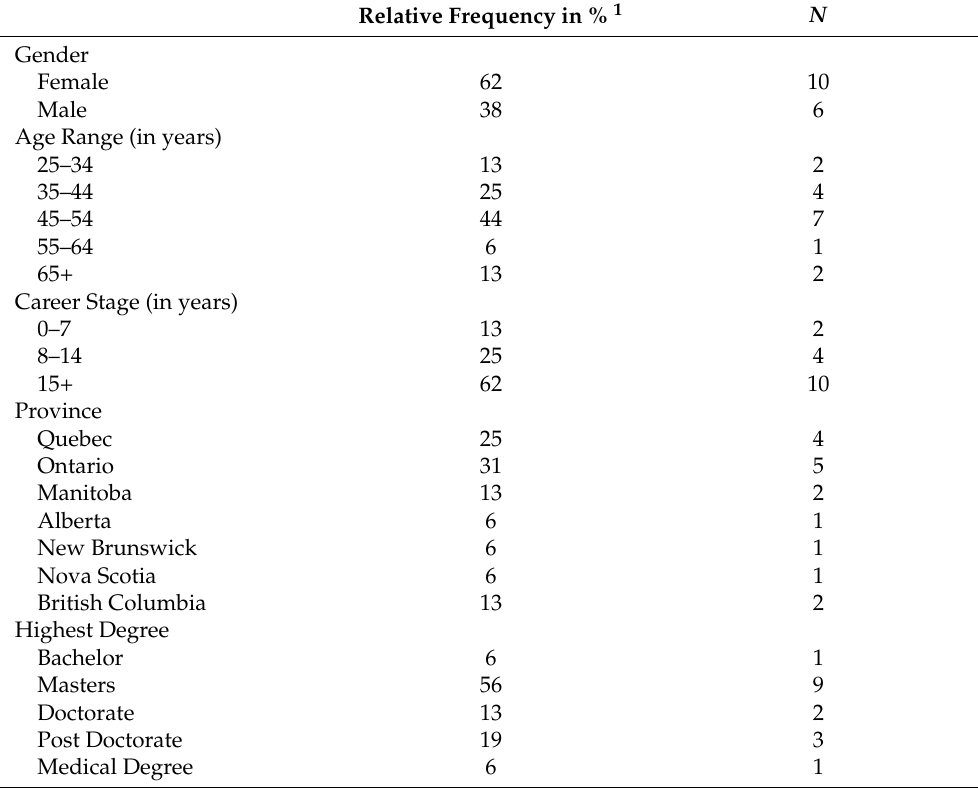
Table 1. Sociodemographic characteristics of participants ( N = 16). Relative Frequency in %